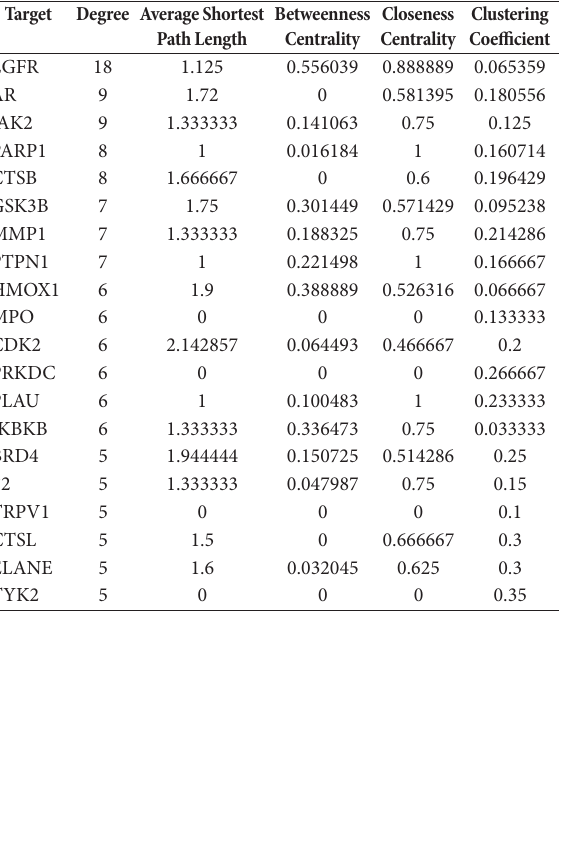
Table 2. The top 20 targets of CSL related to COVID-19. Target Degree Average Shortest Path Length